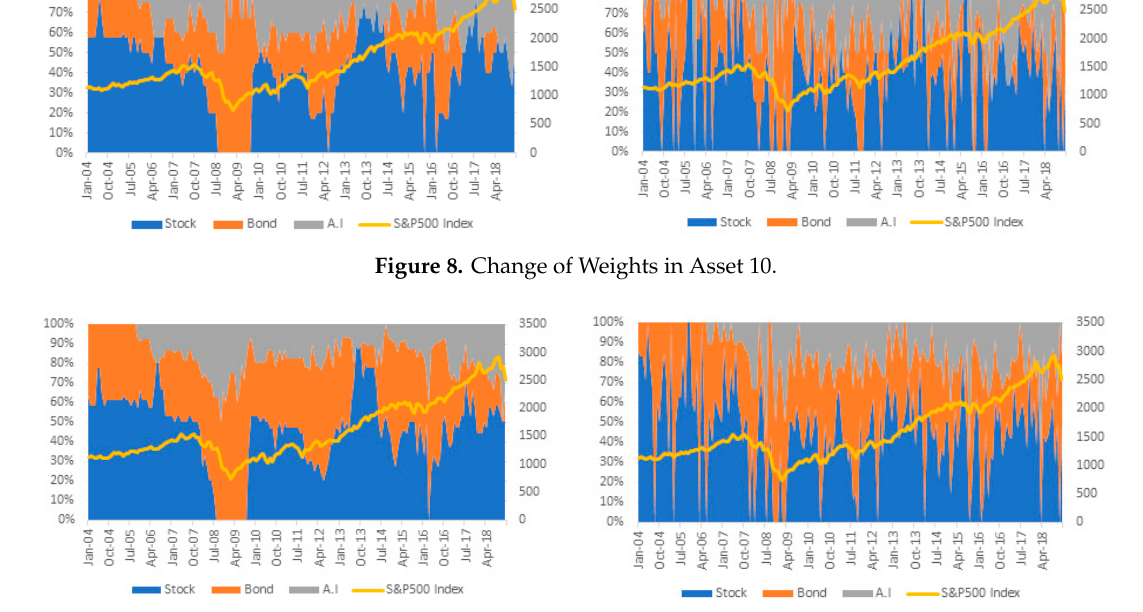
Figure 9. Change of Weights in Asset 22.